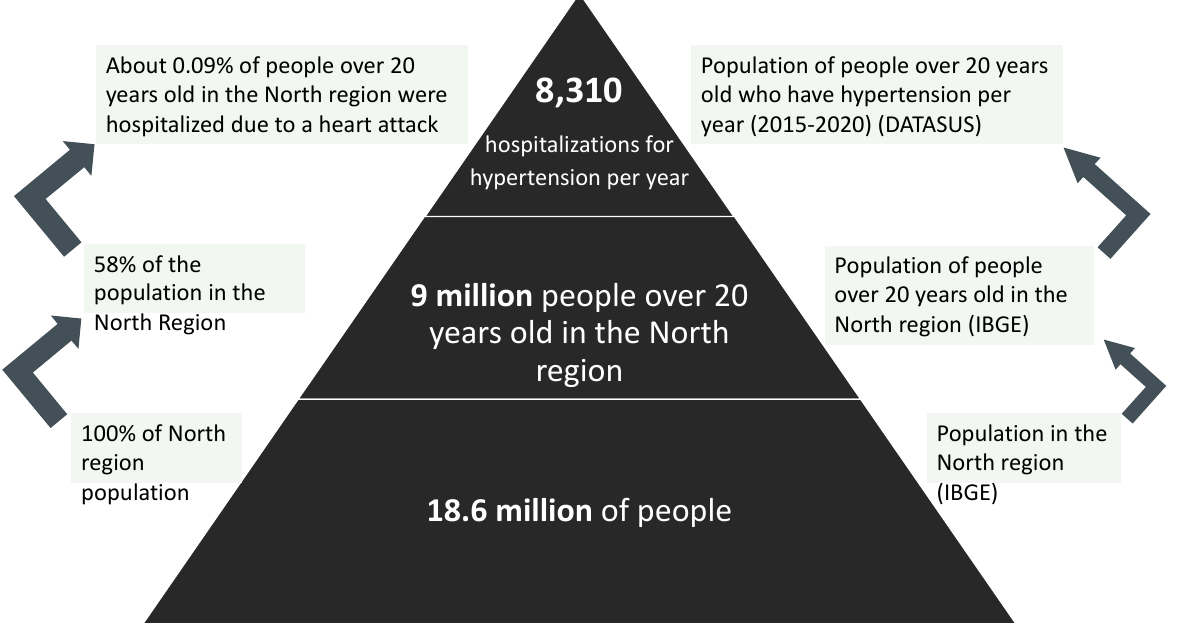
Figure 3. Hypertension scenario in Northern Brazil.